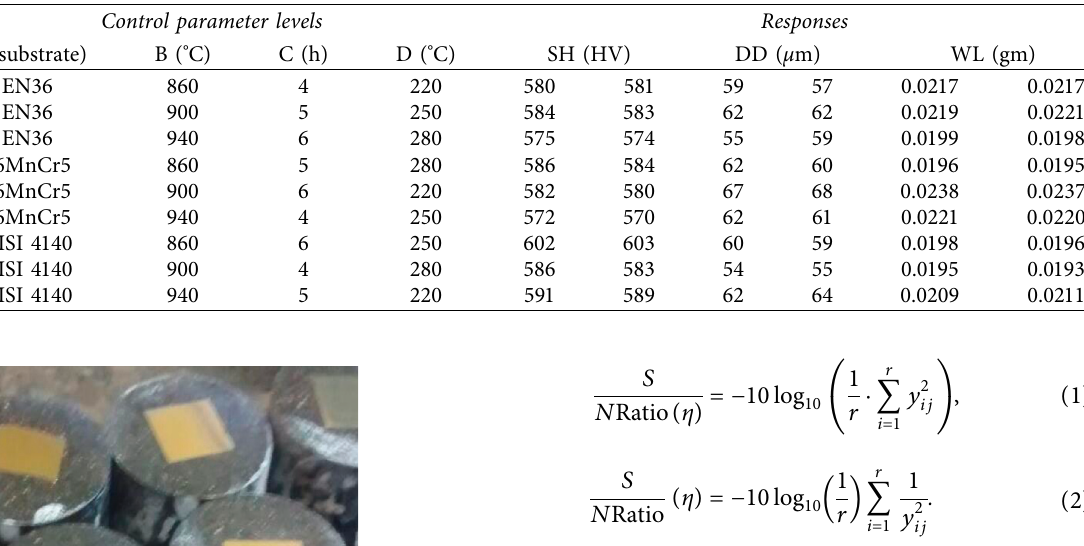
Table 2: Trials and responses.